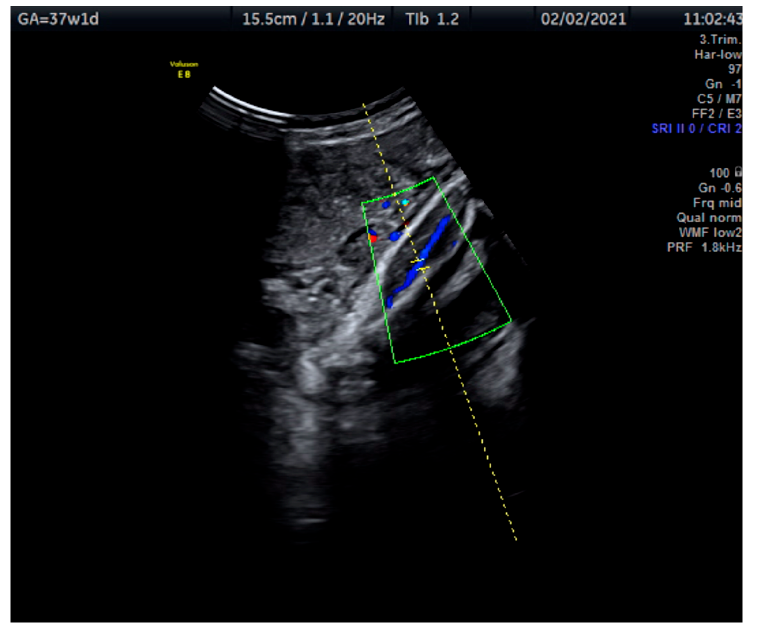
Figure 1. This Doppler image shows the technique of the measurement of the blood flow of the tibial artery of the fetal lower extremity with the tibial and fibular bones clearly visible. The measurement was taken at 37 + 1 weeks.